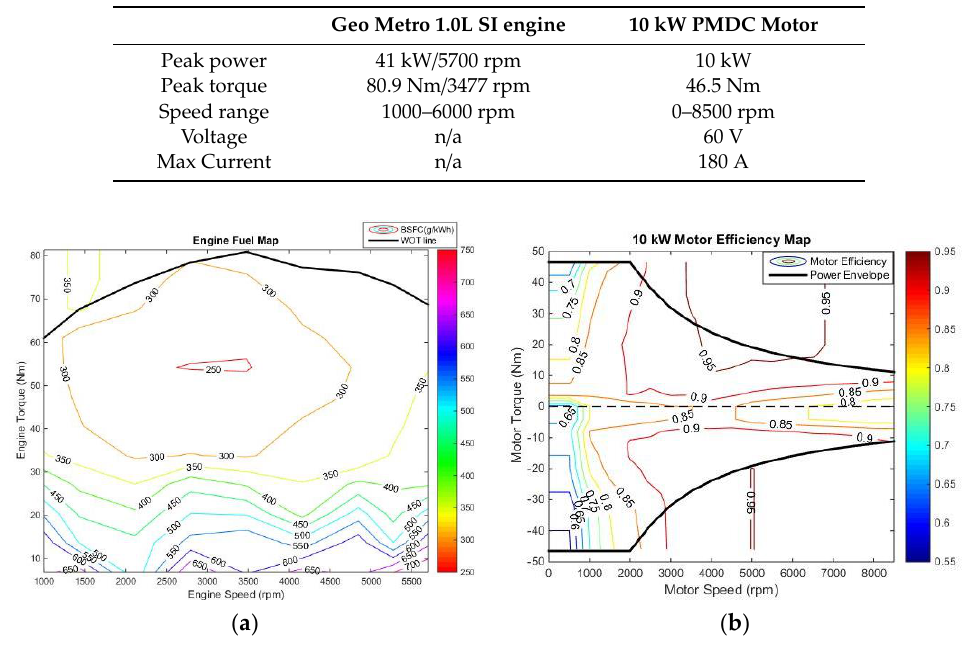
Figure 2. ( a ) Engine map and ( b ) electric motor (EM) map.